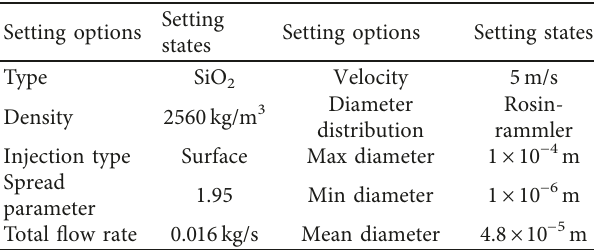
Table 3: Parameter settling of the dust.